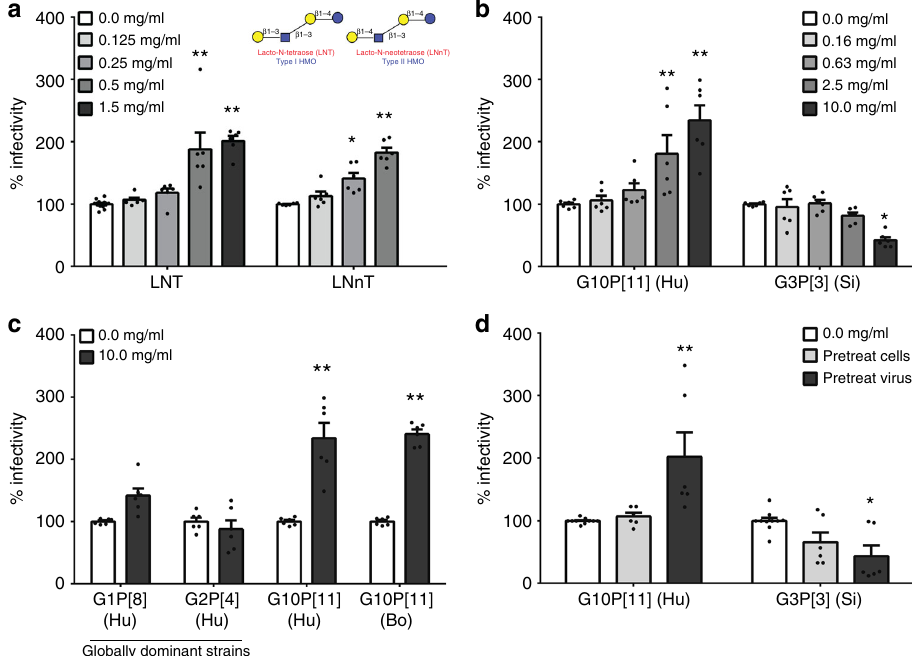
Fig. 1 Human milk oligosaccharides are not decoy receptors for G10P[11] rotavirus. A dose-dependent enhancement in G10P[11] infectivity was seen with a type I HMO Lacto- N -tetraose (LNT) and type II HMO Lacto- N -neo-tetraose (LNnT) as well as b pooled HMOs. The structures of LNT and LNnT are shown in a , with the blue circle representing glucose, yellow circle representing galactose, and the blue square representing N -acetylglucosamine. This effect was speci fi c to P[11] rotaviruses when compared to the reduction in infectivity for a simian (Si) G3P[3] rotavirus ( b ) and other globally dominant human rotavirus strains G1P[8] and G2P[4] ( c ). The HMO effects are mediated by an effect on the virus rather than the cells ( d ). All bars represent the mean percentage of infectivity with error bars denoting standard error of mean from a minimum of three independent experiments. No HMO treatment was considered 100% infectivity. The mean baseline titers [expressed in fl uorescent focus units (FFU) per ml] for each virus strain used to denote 100% infectivity in this fi gure are: human G10P[11] — 8.0 × 10 5 FFU/ml; bovine G10P[11] — 8.2 × 10 5 FFU/ml; G3P[3] — 2.4 × 10 7 FFU/ml; G1P[8] — 1.2 × 10 7 FFU/ ml; G2P[4] — 6.0 × 10 6 FFU/ml; p value <0.05 (analysis of variance with Dunnett ’ s post hoc test) was considered statistically signi fi cant (* p < 0.05, ** p <